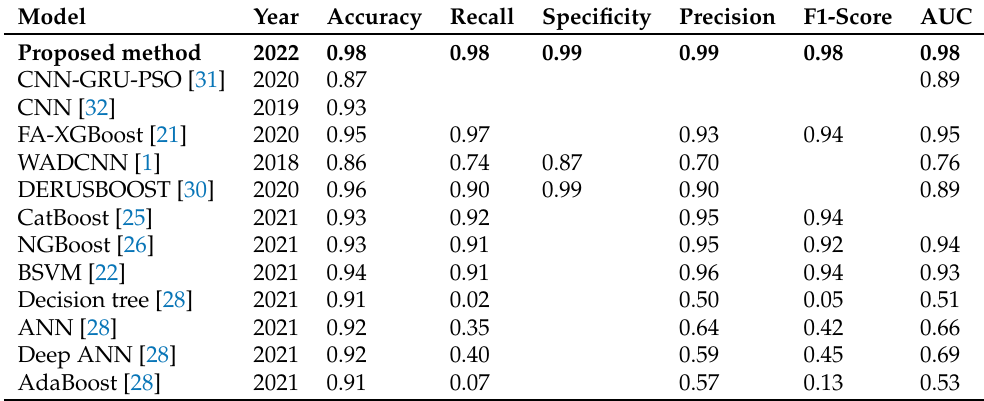
Table 6. The comparison of the proposed method’s results with other